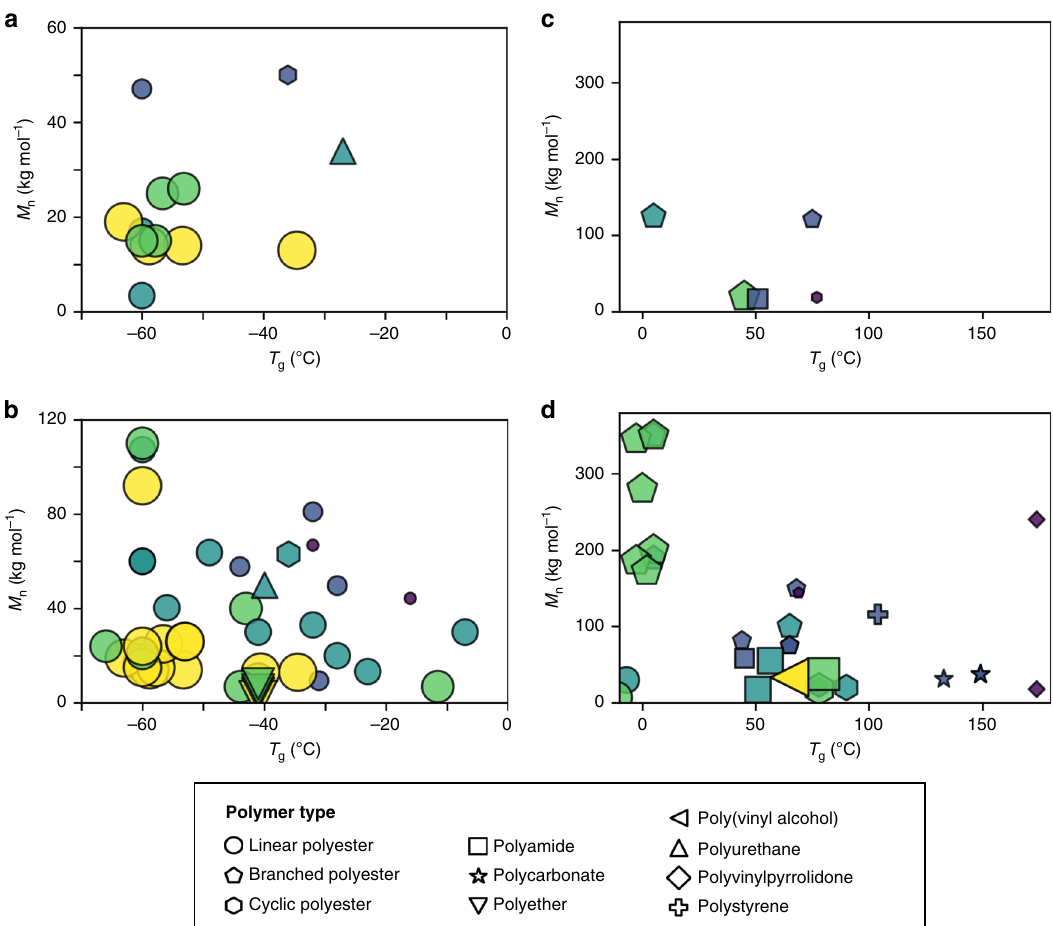
Fig. 3 Effect of T g and M n on polymer degradation. a Abiotic processes for T g values < 0 °C, b biotic processes and photo-initiated oxidation for T g values < 0 °C, c abiotic processes for T g values > 0 °C, d biotic processes and photo-initiated oxidation for T g values> 0 °C. Degradation cate g ories depicted on 5-tier scale and shown by size of data point and color (yellow > light green > green > blue >